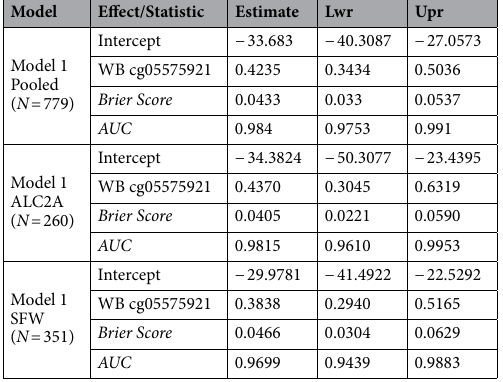
Table 4. Model 1 (WB DNA) Parameter estimates and calibration statistics with 95% CI bounds for the pooled data (top), ALC2A (middle), and SFW (bottom).